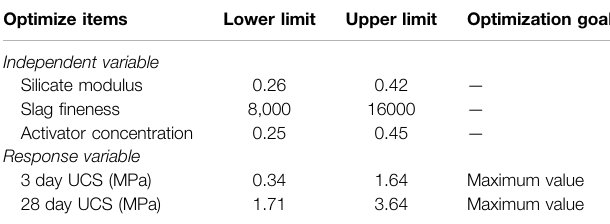
TABLE 5 | Optimization criteria for